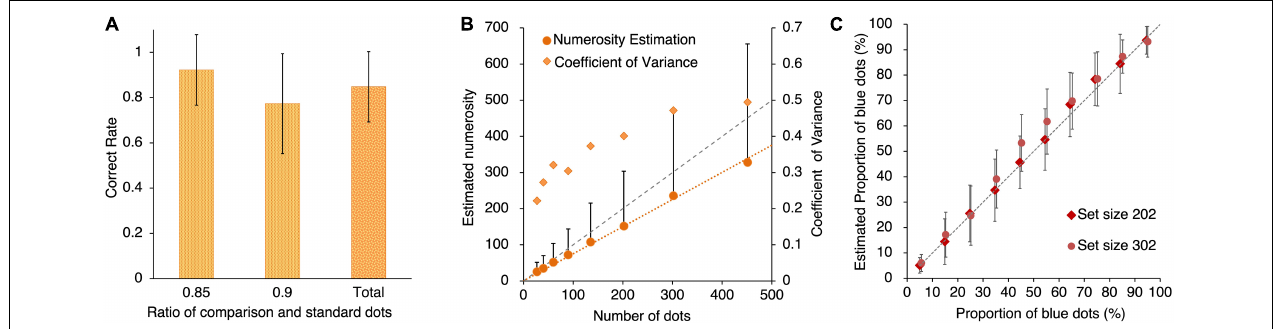
FIGURE 2 | (A) Mean correct rate of the numerosity comparison task. Error bars shows the standard deviation. (B) Mean estimated numerosity and coefficient of variance (CV) as a function of the number of actual dots in the numerosity estimation task. Error bars shows the standard deviation. (C) Mean of estimated proportion of blue dots as a function of actual proportion of blue dots. Error bars shows the standard